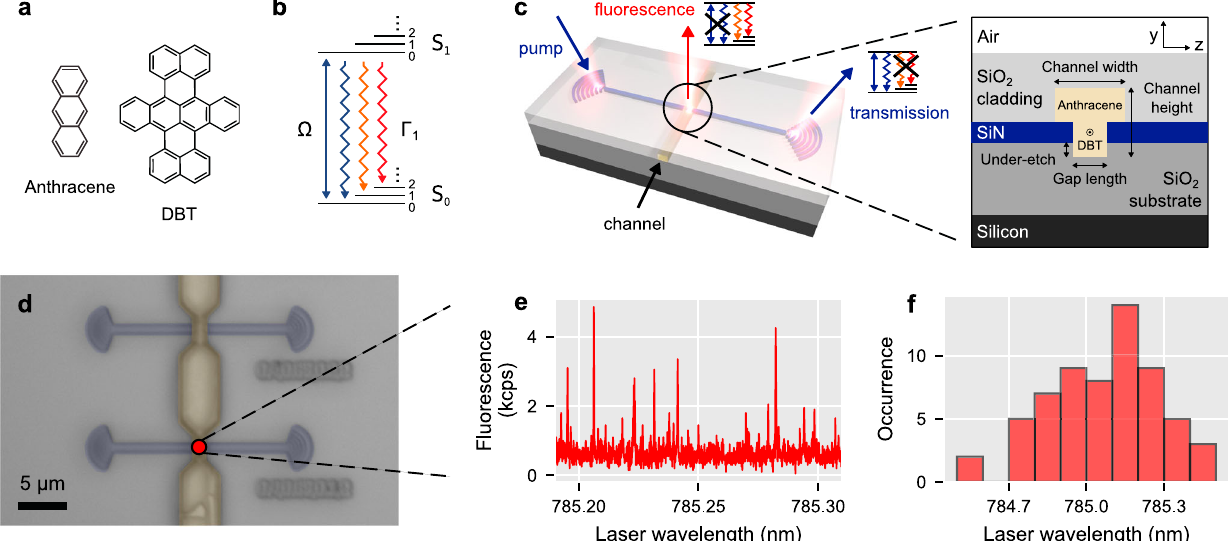
Fig. 2 Localised growth of DBT-doped anthracene in the vicinity of an interrupted waveguide. a Molecular structure of anthracene and dibenzoterrylene (DBT). b Jablonski diagram of DBT ground (S 0 ) and excited (S 1 ) states excited at Rabi frequency Ω and decaying with rate Γ 1 . Triplet states are ignored as the inter-system crossing is very weak 33 . c Overview of the grating couplers, the interrupted silicon nitride (SiN) waveguide and the micro fl uidic channel crossing it. The zoom-in shows details of the intersection between guide and channel. d False-colour optical-microscope image of two devices with the micro fl uidic channels fi lled. e Fluorescence excitation spectrum of molecules near the gap in a device at cryogenic temperature. The molecules are excited from the “ pump ” waveguide and fl uorescence is collected by the confocal microscope from the red dot shown in d . f Wavelength distribution of the DBT resonances from the same confocal